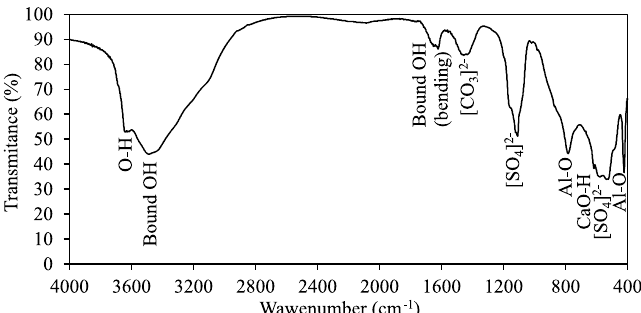
Figure 4. FTIR spectrum of the sample after hydrothermal